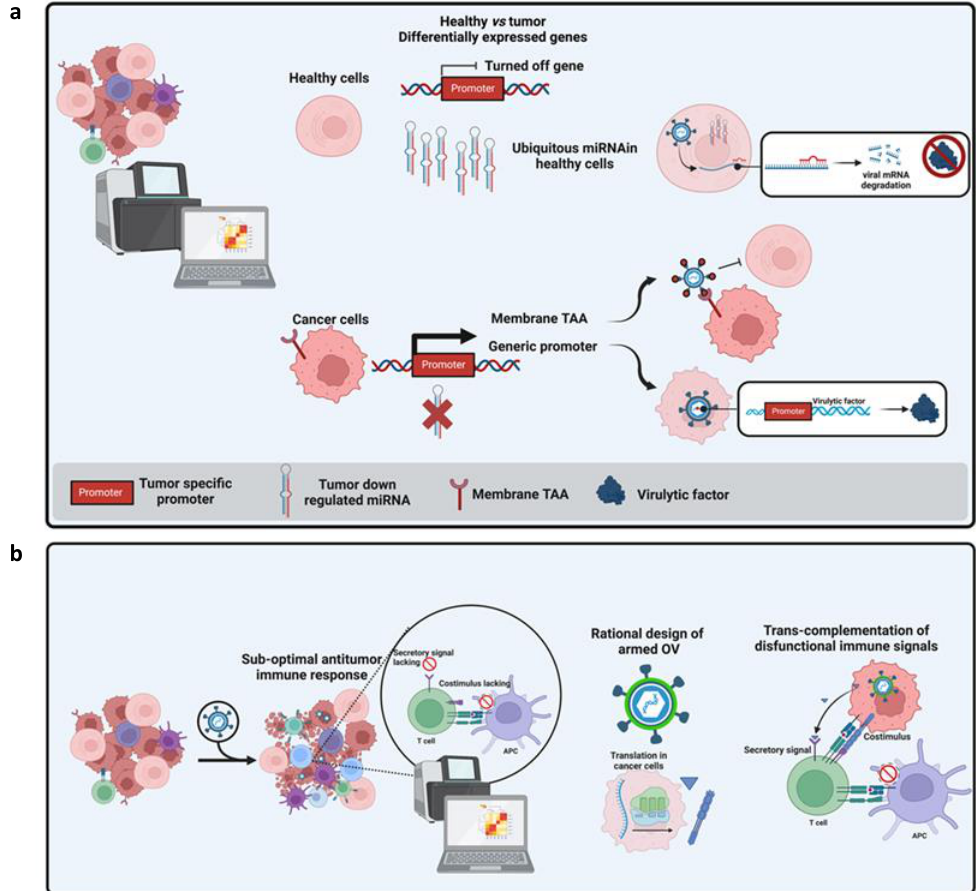
Figure 4. ( a ) Modalities to restrict tropism or replication of OVs based on multi-omics data. In the cartoon, a tumor transcriptome is compared to those of healthy tissues to identify differentially expressed genes (DEG). These genes have been reported as down-regulated or up-regulated in tumors. Different approaches can exploit these DEGs: when a miRNA is solely expressed in healthy tissues but is absent in cancer cells, matching seed sequences can be ectopically incorporated into the 3′ UTR of the viral gene to inhibit the translation of a given virulence factor in healthy tissues while preserving its functionality in tumor cells (1). By contrast, when a tumor-associated promoter is identified, its regulatory region can be used to replace endogenous viral promoters to allow transcription only in tumor cells (3). Finally, a membrane associated TAA, represented as generic receptor in the cartoon, can be targeted by targeted OVs where viral glycoproteins can host a bait to interact with the TAA. This bait can be an antibody fragment or even a ligand of TAA. ( b ) The concept of rational arming of OVs is represented. Perturbation in transcriptomic profiling of tumor bulk make it possible to identify sub-optimally activated immune pathways whose function can be improved by encoding the matching factors into the OV genome.